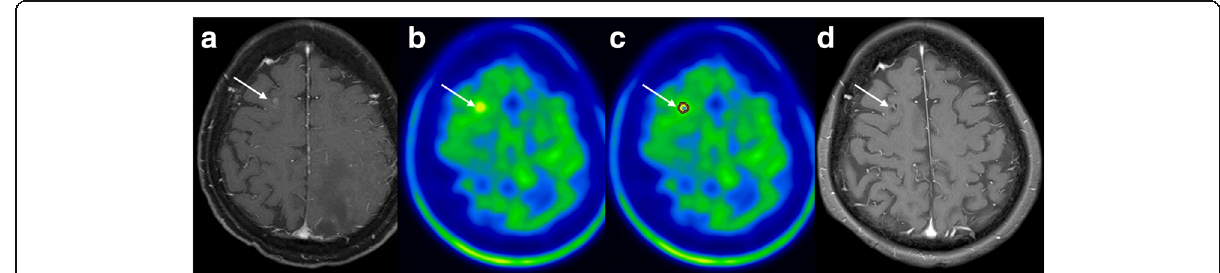
Fig. 1 Imaging of a 75-year-old woman who underwent gamma knife radiosurgery (GKR) at a dose of 18 Gy for metastatic brain tumor that originated from lung adenocarcinoma. a T1-weighted MR image with gadolinium enhancement showing contrast-enhanced lesion in the right frontal lobe ( arrow ). b 11 C-MET PET image showing mild focal tracer uptake corresponding to enhanced lesion on MR image ( arrow ). c Metabolic tumor volume (MTV) was 0.156 cm 3 ( arrow ). T/N ratio was 1.29, which was lower than the non-corrected cutoff value (1.61) but more than the MTV-corrected cutoff value (1.23). d This lesion was determined as recurrence by definition, the size of which significantly decreased after repeated GKR over 4 months as observed in a follow-up MR image ( arrow